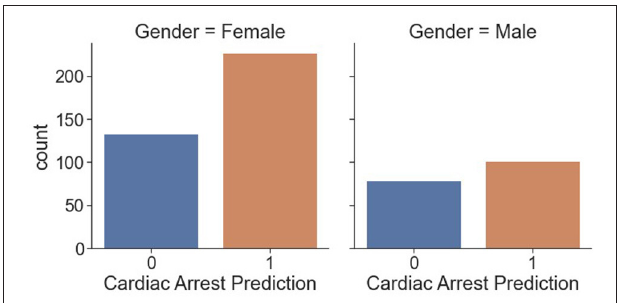
FIGURE 7 | Counts of men and women.